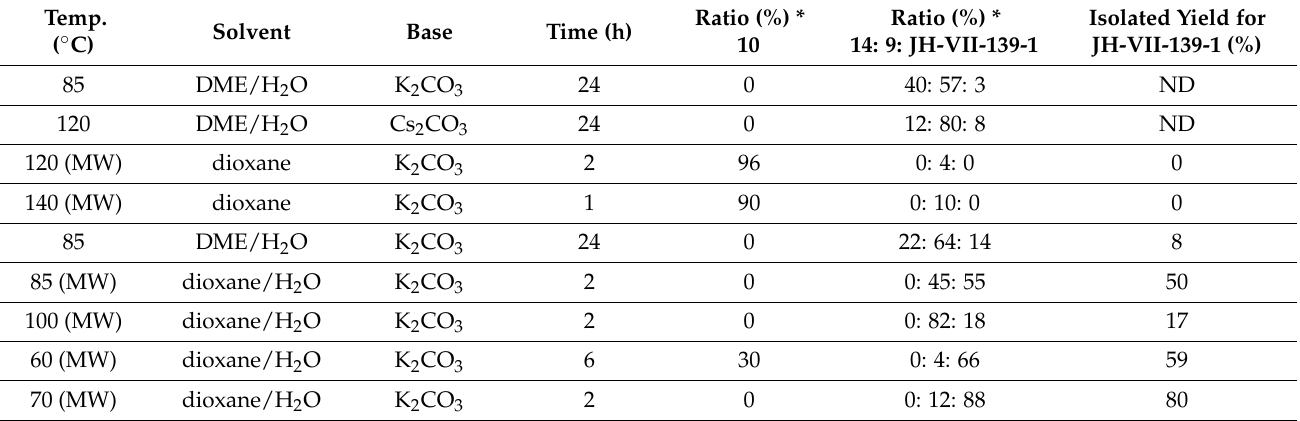
Table 1. Suzuki–Miyaura coupling conditions for JH-VII-139-1. Reaction conditions: all reactions were carried out using triflate 10 (1.2 equiv), boronic acid 13 (1 equiv), Pd(dppf)Cl 2 as catalyst (5%) and tBuXPhos